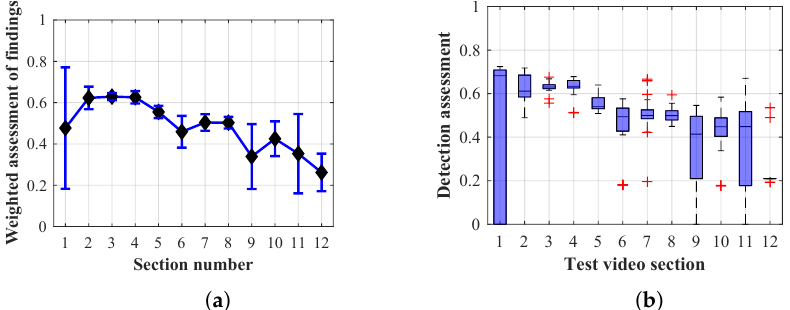
Figure 33. Results of Method 1.3 with a lifespan of 1 frames. ( a ) the weighted average rating with the average mean absolute error of the weighted rating and ( b ) boxplots of the distribution of the statistical sets of the results of the individual sections evaluated indicating: minimum, 1st quartile, median, 3rd quartile, maximum.